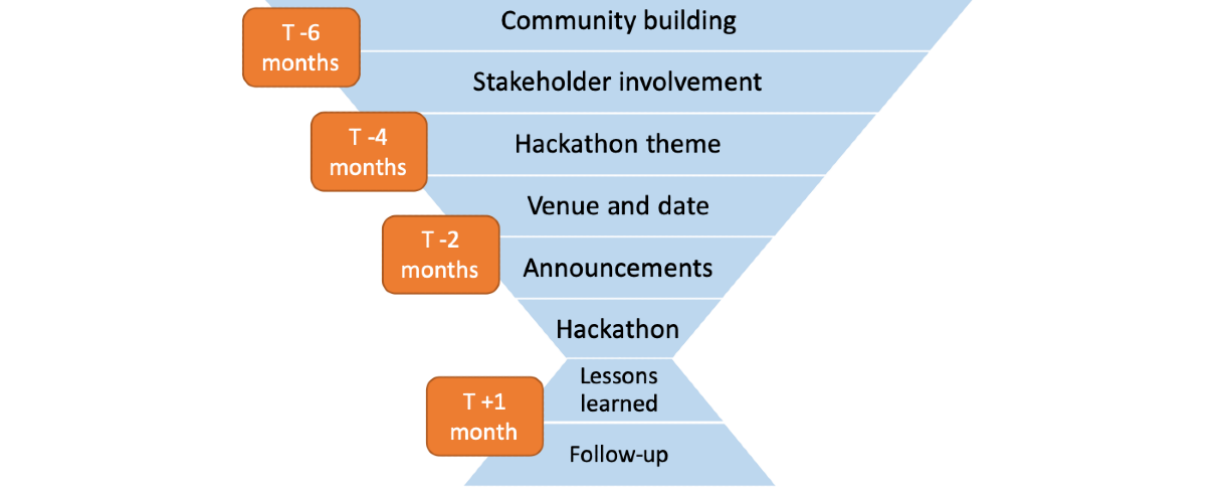
Figure 3. Systematic recommendation for conducting a cost-efficient hackathon with 30 or fewer participants. The time (T) to action is visualized in orange boxes. The hackathon occurs at